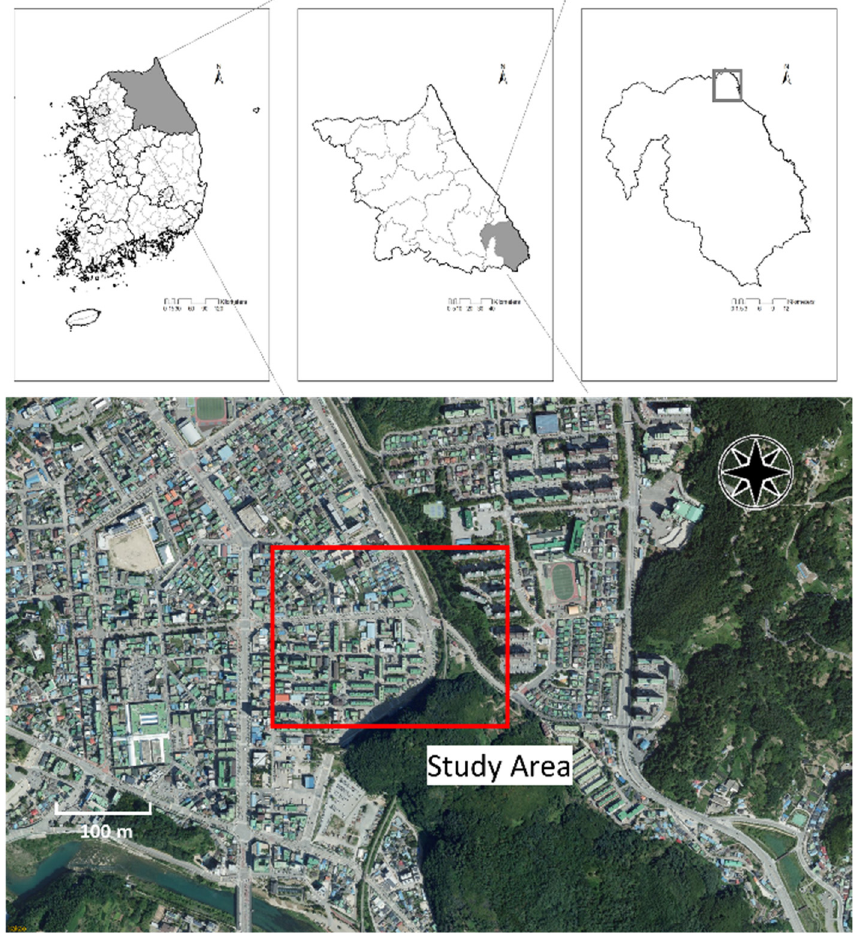
Figure 6. Study area in Samcheok City, Gangwon-do, Korea.